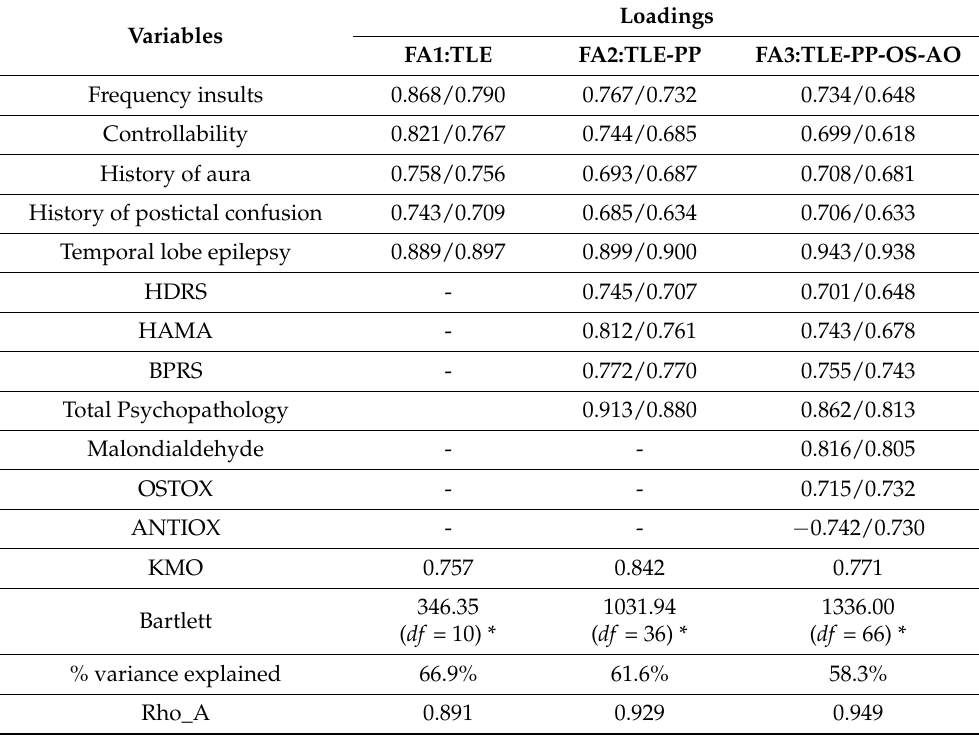
Table 1. Results of principal components (PCA) and confirmatory factor (CFA) analysis. Loadings Variables FA1:TLE